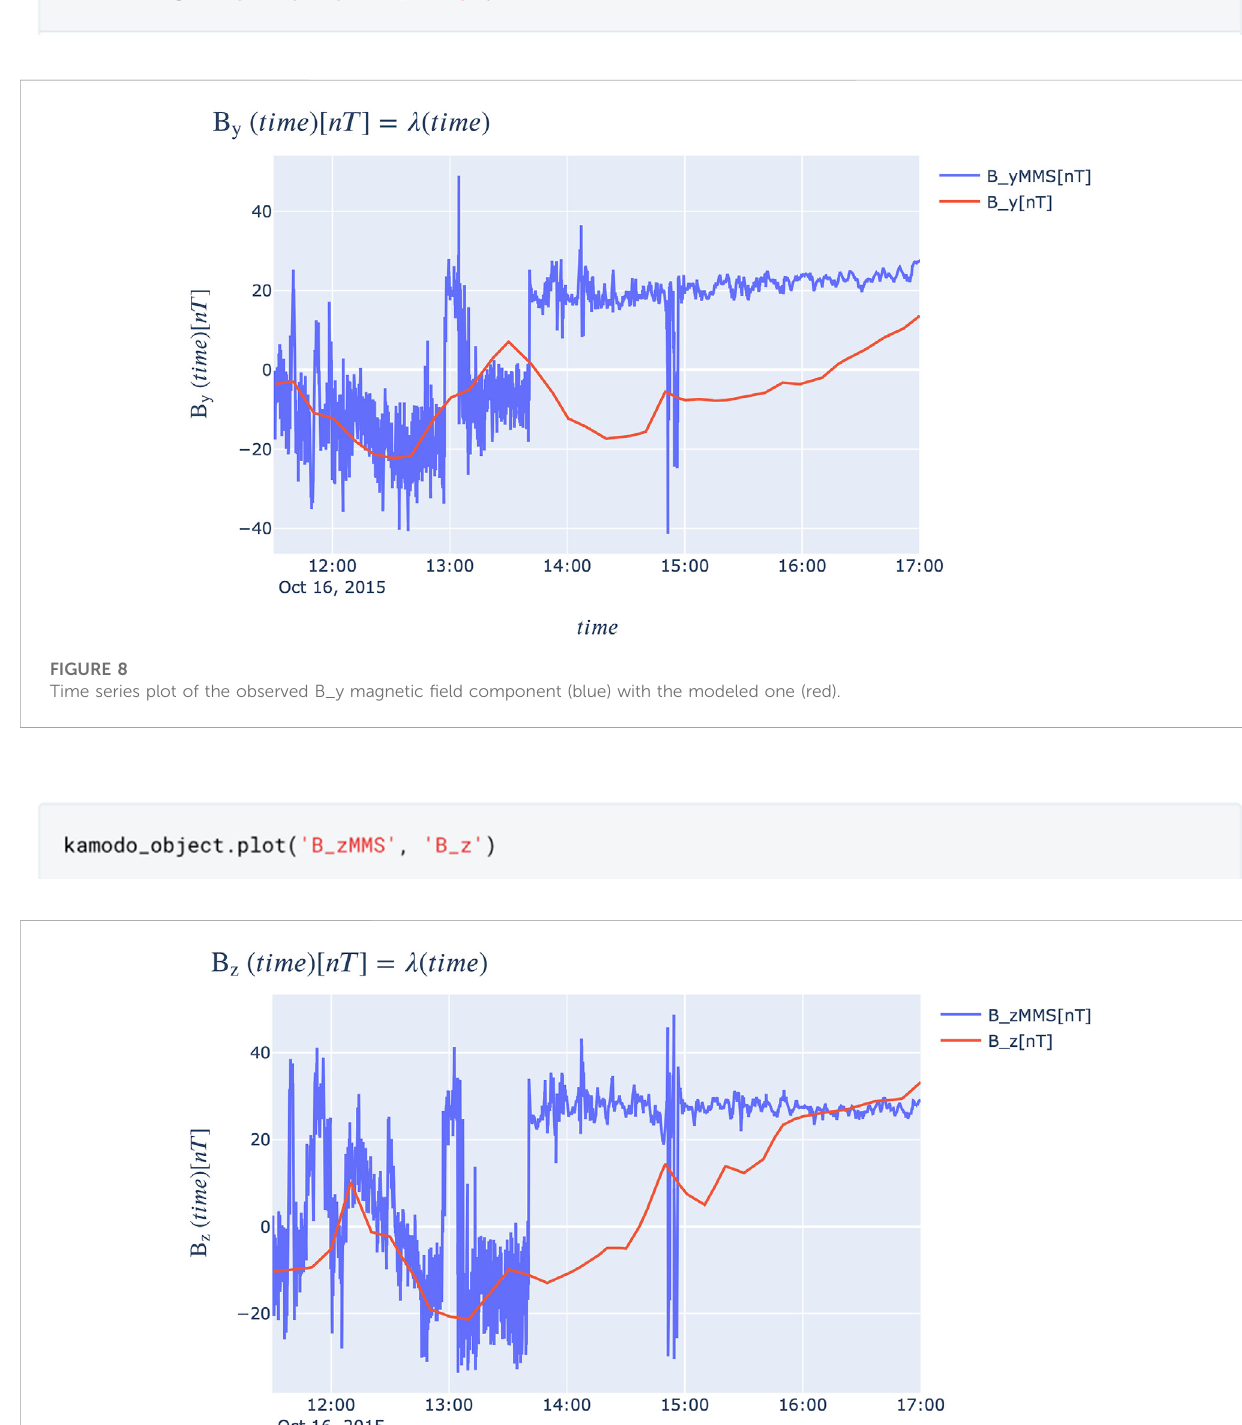
Frontiers in Astronomy and Space